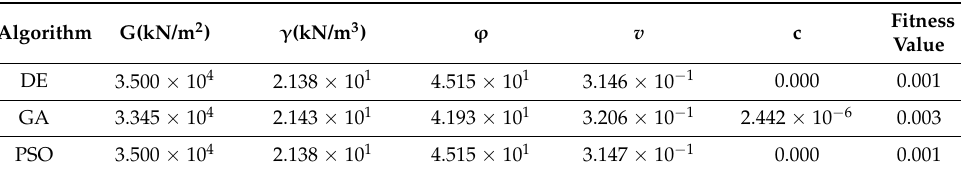
Table 3. Values obtained using three different algorithms for the parameters in zone P using the inverse analysis procedure. The fitness value is the error function calculated for the entire population.